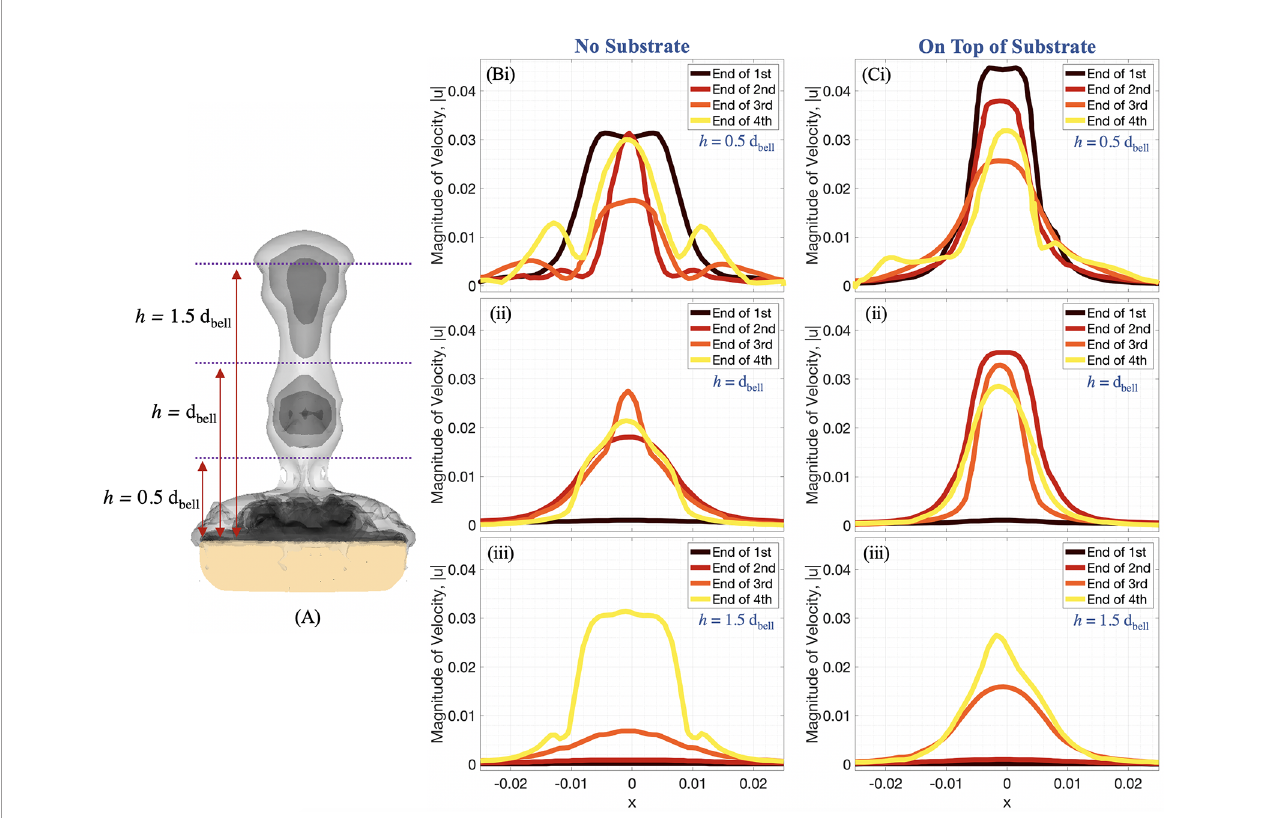
FIGURE 11 | (A) Radial distribution of 3D velocity magnitude (in units of m s -1 ) obtained from numerical simulations, computed along horizontal lines above the bell with (B) no substrate and (C) sitting on a substrate. The horizontal lines are drawn at distances of (i) 0.5 d bell , (ii) d bell , and (iii) 1.5 d bell above the bell. Each plot provides the data at the end of the fi rst, second, third, and fourth pulsation cycles. All distances are in units of m.